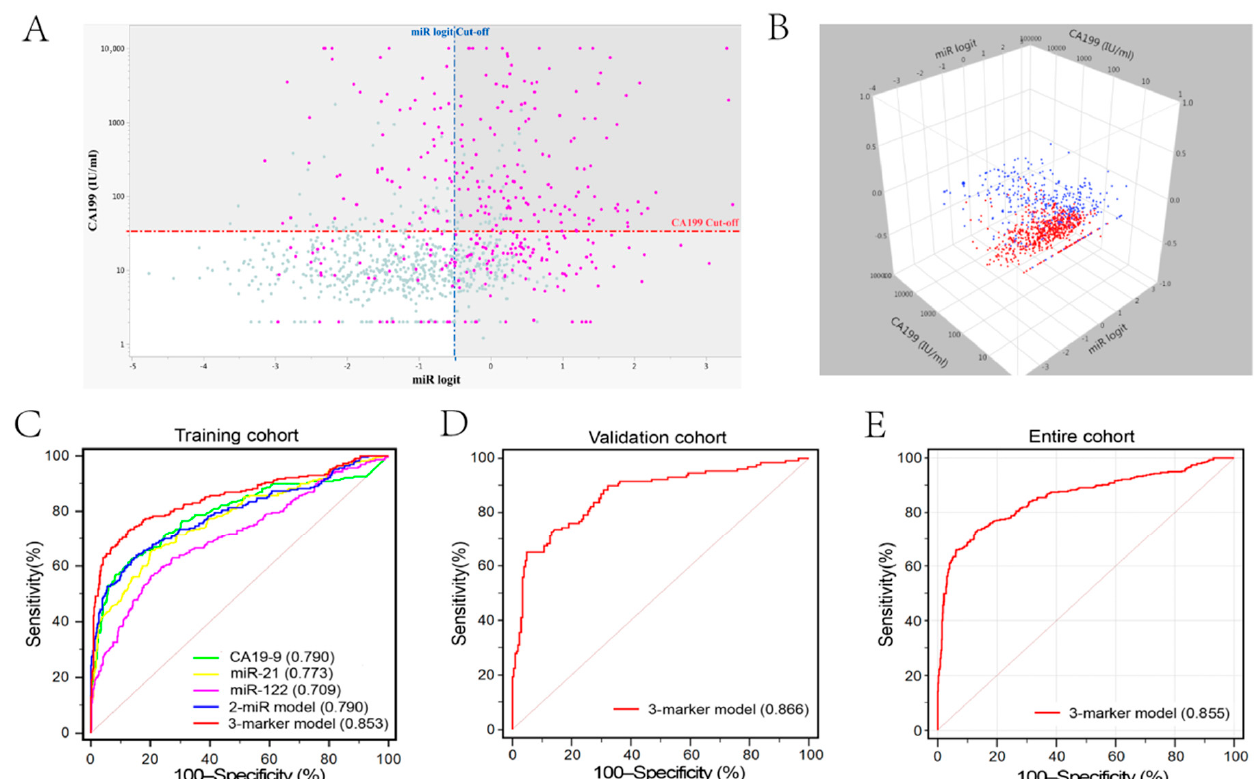
Figure 3. Diagnostic performance of CA19-9, miR-21, miR-122, 2-miR model and 3-marker model for iCCA. ( A , B ) The demonstration of CA19-9 level and 2-miR model in entire cohort by using two-dimension scatterplot and three-dimension scatterplot. iCCA patients (87.7%, 315/359) could be diagnosed by a combination of CA19-9 level and 2-miR model (gray shadow region). Red dotted line, cut-off value for CA19-9 (34 IU/mL); blue dotted line, cut-off value for 2-miR model ( − 0.494). ( C ) Diagnostic performance of five parameters for iCCA diagnosis in the training cohort. The AUC of three-marker model was significantly larger than CA19-9 ( p = 0.009), miR-21 ( p < 0.001), miR-122 ( p < 0.001), and 2-miR model ( p < 0.001). ( D , E ) Diagnostic performance of three-marker model in the validation cohort and entire